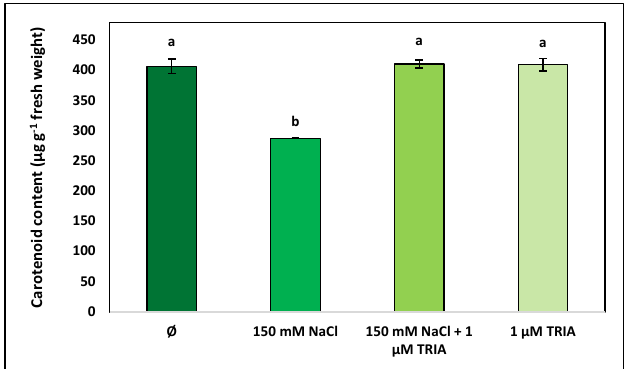
Fig. 8: Influence of TRIA on vitamin C content and on reduced ascorbic acid (ASC) to oxidized dehydroascorbate (DHA) ratio of spinach leaves exposed to salt stress. Ø stands for the control group. Vertical bars represent ± standard error from means (n=5), different letters above the columns indicate significant differences at P < 0.05 (Tukey’s HSD test)